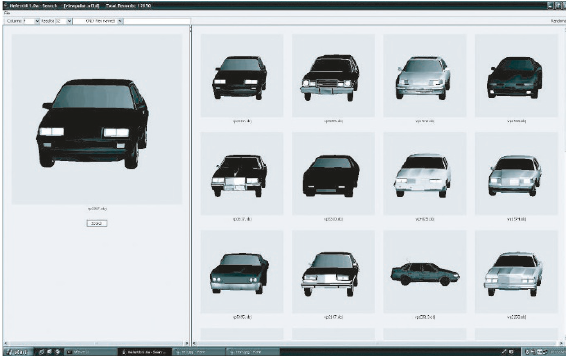
Figure 3: Retrieval of cars. Most of the cars (approximately 90%) were retrieved without inlayers from the 12 . 150 objects database. Only the first results are displayed.